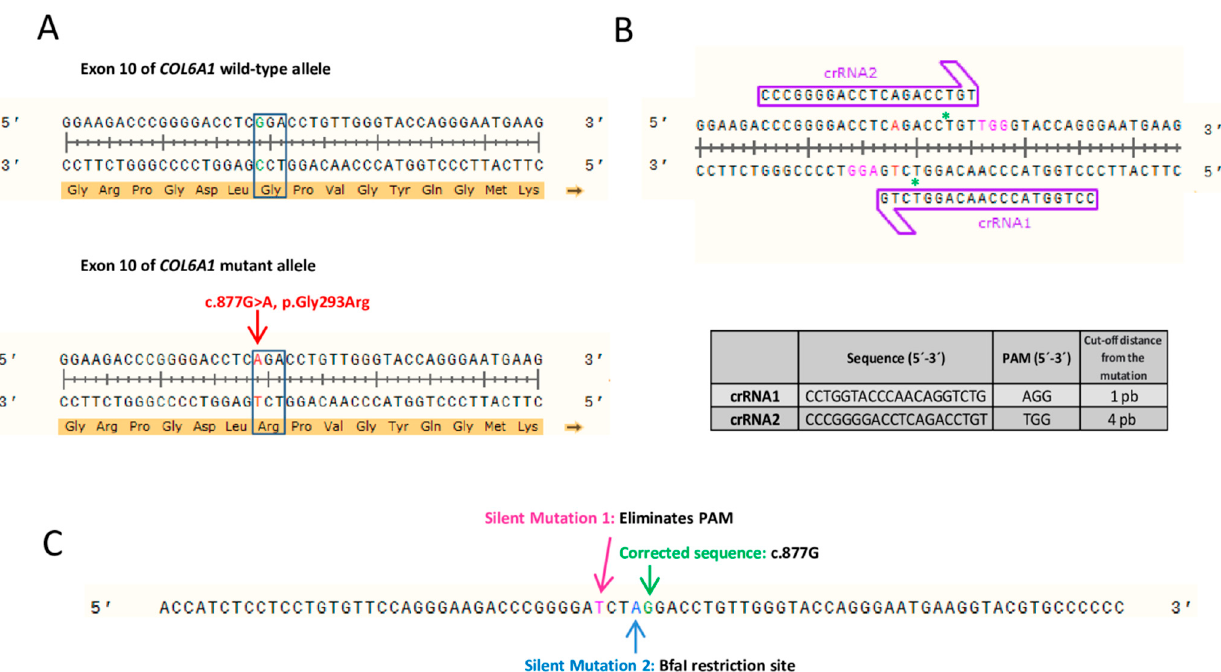
Figure 1. Strategy for CRISPR/Cas9 editing of c.877G>A variant in exon 10 of COL6A1 . ( A ) The c.877G>A, p.Gly293Arg dominant-negative pathogenic variant is heterozygous in the cohort of individuals studied here. ( B ) Schematic representation of the experimental design of the two RNA guides (crRNA1 and crRNA2). Mutant adenine is shown in red. Protospacer adjacent motif (PAM) sequences are highlighted in pink for each crRNA. Green asterisks (*) represent the predicted Cas9 cleavage site for each crRNA. The table shows the sequence of each of the crRNAs, their corresponding PAM and the nucleotides that separate the Cas9 cut-off point of the variant. ( C ) Sequence of the single-stranded DNA template delivered to fibroblasts to correct the pathogenic variant by homology- directed repair. In addition to the wild-type guanine nucleotide at position c.877, it contains two extra silent changes to eliminate the PAM and generate a restriction site for the